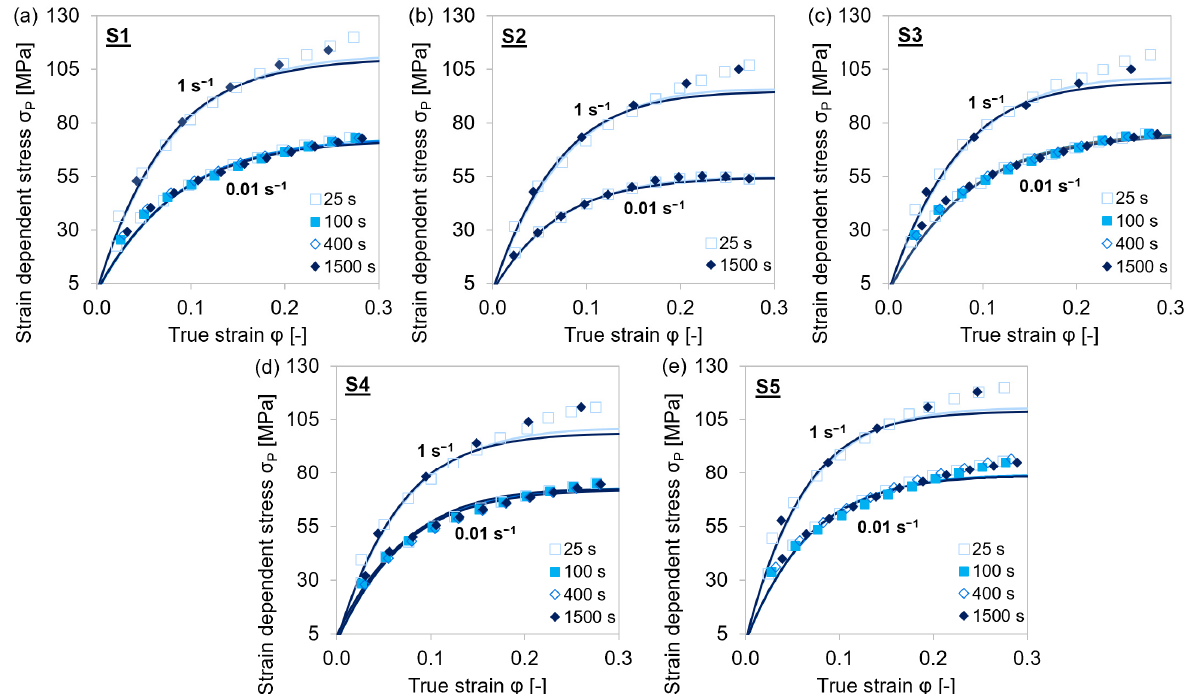
Figure 12. Comparison of experimental σ P (symbols) and simulated (lines) flow curves during single-hit compression tests with 25–1500 s holding times before deformation and 0.01–1 s − 1 strain rates at 1153 K. ( a – e ) MA steels